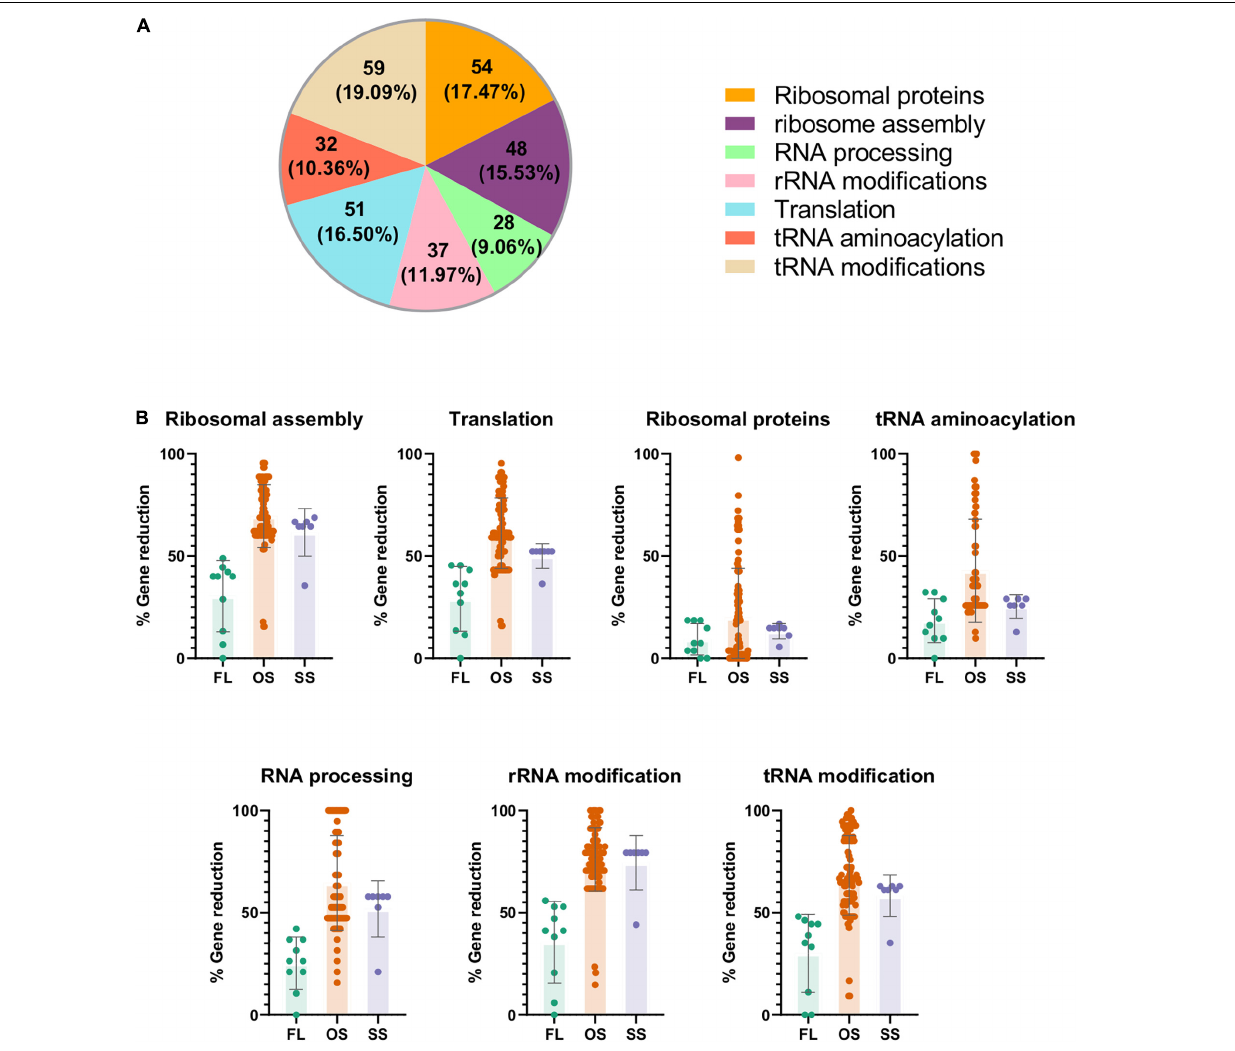
FIGURE 2 | Representation and analysis of the universe of translational genes in the data under study. The complete list of genes can be found in Supplementary Material 2. (A) Translational set composed by 309 genes after manual curation. (B) Gene reduction level of the genomes under study measured as percentage of translational orthologs not detected in each organism related to the maximum number of genes found in each translational category of the dataset. FL: free-living. OS: obligate endosymbiont. SS: secondary symbiont.